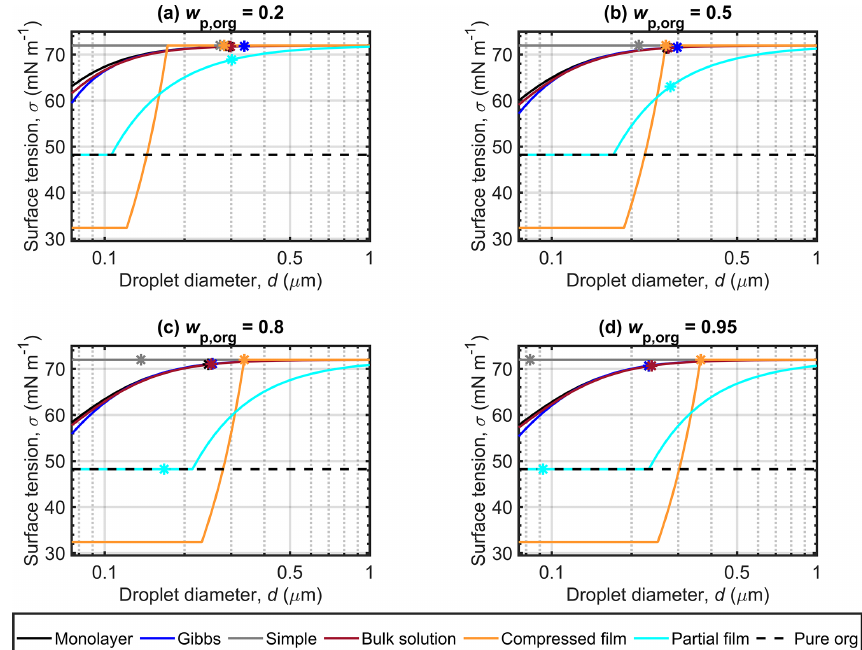
Figure 3. Surface tensions of droplets along the Köhler curves, calculated with the different models for dry particles of D p = 50nm at different malonic acid mass fractions ( w p , org ). The critical points evaluated for the Köhler curves in Fig. 2 are also marked, and the surface tension of supercooled pure malonic acid estimated though the fit of Hyvärinen et al. (2006) is indicated as a physical lower limit for the droplet surface